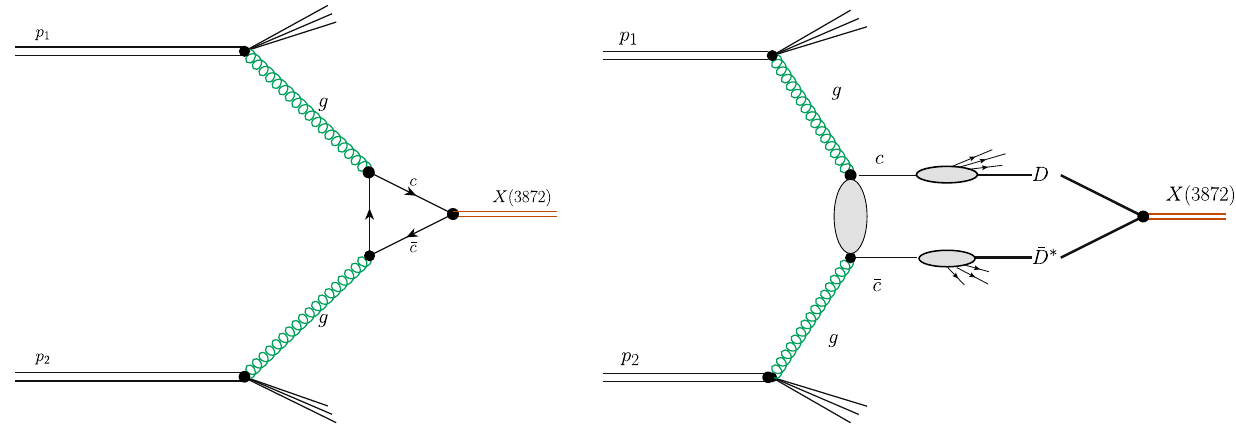
Fig. 1 Generic diagrams for the inclusive process of X ( 3872 ) production in proton–proton scattering via two gluons